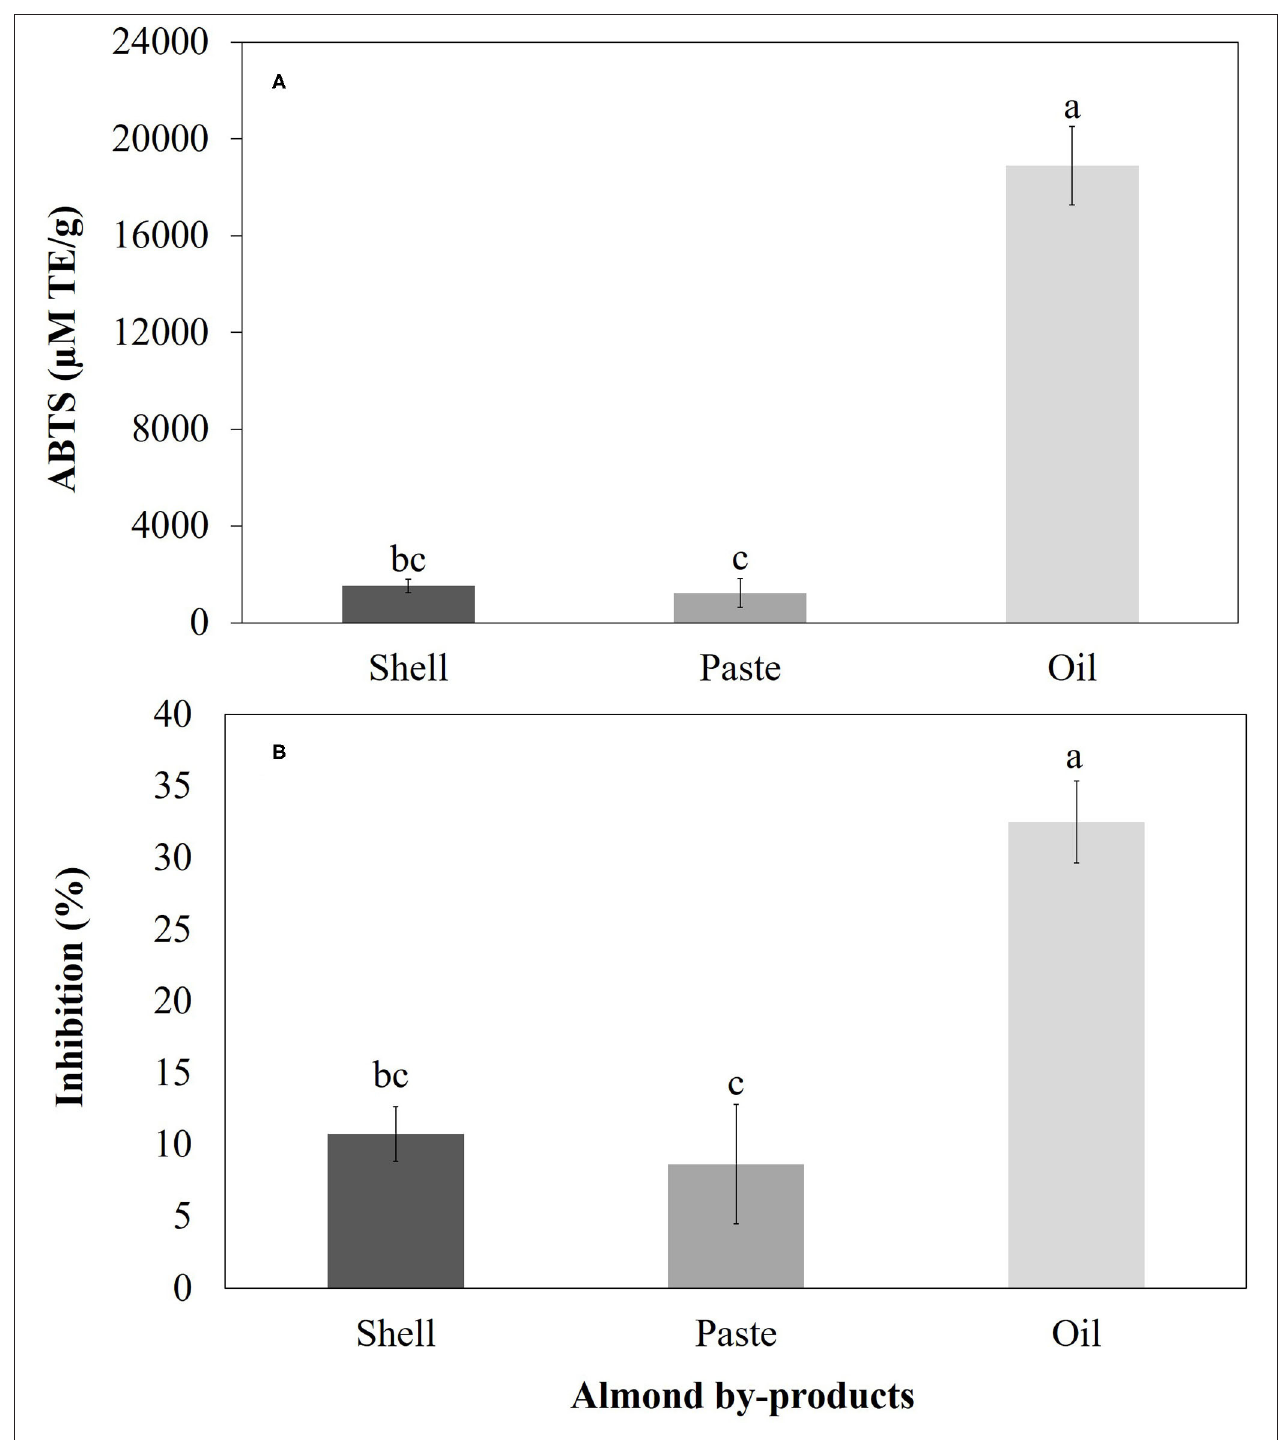
FIGURE 5 | (A) Antioxidant activity and (B) ABTS radical scavenging activity of various almond by-products extracted with ethanol. The vertical bars indicate mean ± standard deviation ( n = 3).